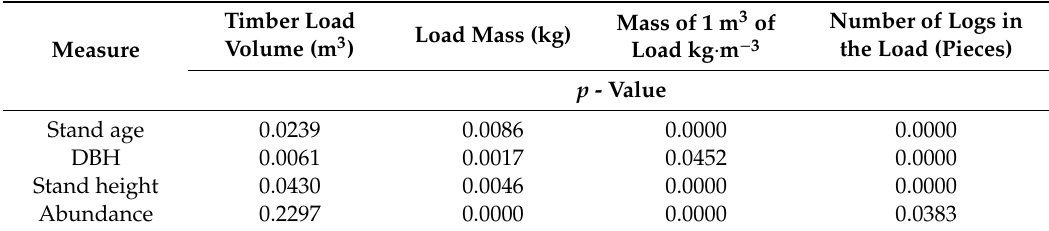
Table 3. The results of the assessment of the significance of the di ff erences of the selected load characteristics depending on the parameters describing the stand.